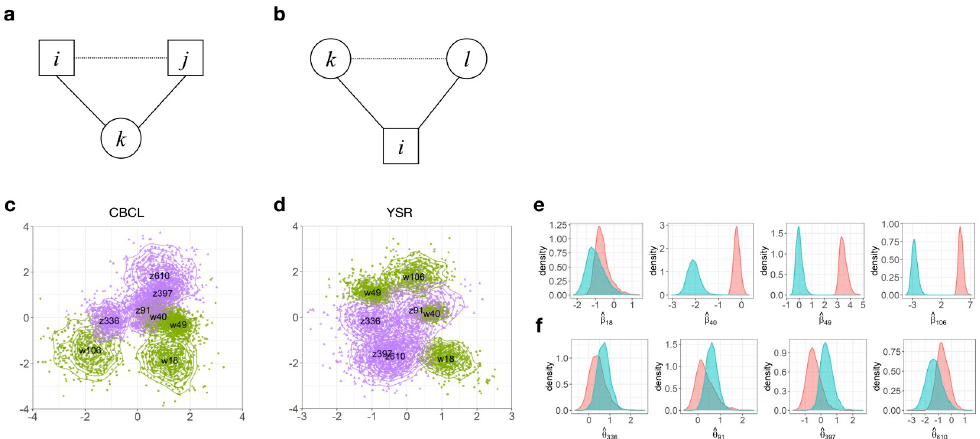
Fig 1. The concept of the distance, position and the latent space (interaction map). (a) and (b) visualize the triangle inequality of the distance. (a) k is a respondent, and i and j are two items. If the positions of two items i and j are close to respondent k in the interaction map, the two items are fairly close to each other, by the triangle inequality. (b) i is an item, and k and l are two respondents. If two respondents k and l are close to the item i , the two respondents k and l are also close. (c) is an example of the posterior distributions of latent positions in the CBCL interaction map, and (d) is the posterior distributions in the YSR interaction map. For visualization, only four items (w18, w40, w49, w106) and four respondents (z91, z336, z397, z610) are displayed. Green dots and lines around the item positions indicate the posterior distributions of the item positions. Purple dots and lines around the person positions indicate the posterior distributions of the person positions. Note that the interaction maps differ for parents (CBCL) and children (YSR). Note also that both item and person positions are located in the same map. The short distance between two latent positions of items (respondents) in the interaction map implies a large dependency between two items (respondents). (e) and (f) present posterior distributions of selected item coefficients (e) and respondent coefficients (f). Blue indicates the CBCL, and red indicates the YSR distributions for each coefficient. All Bayesian inferences are made through these posterior samples; thereby flexible inference such as variance or overlapped portion with other distribution can be